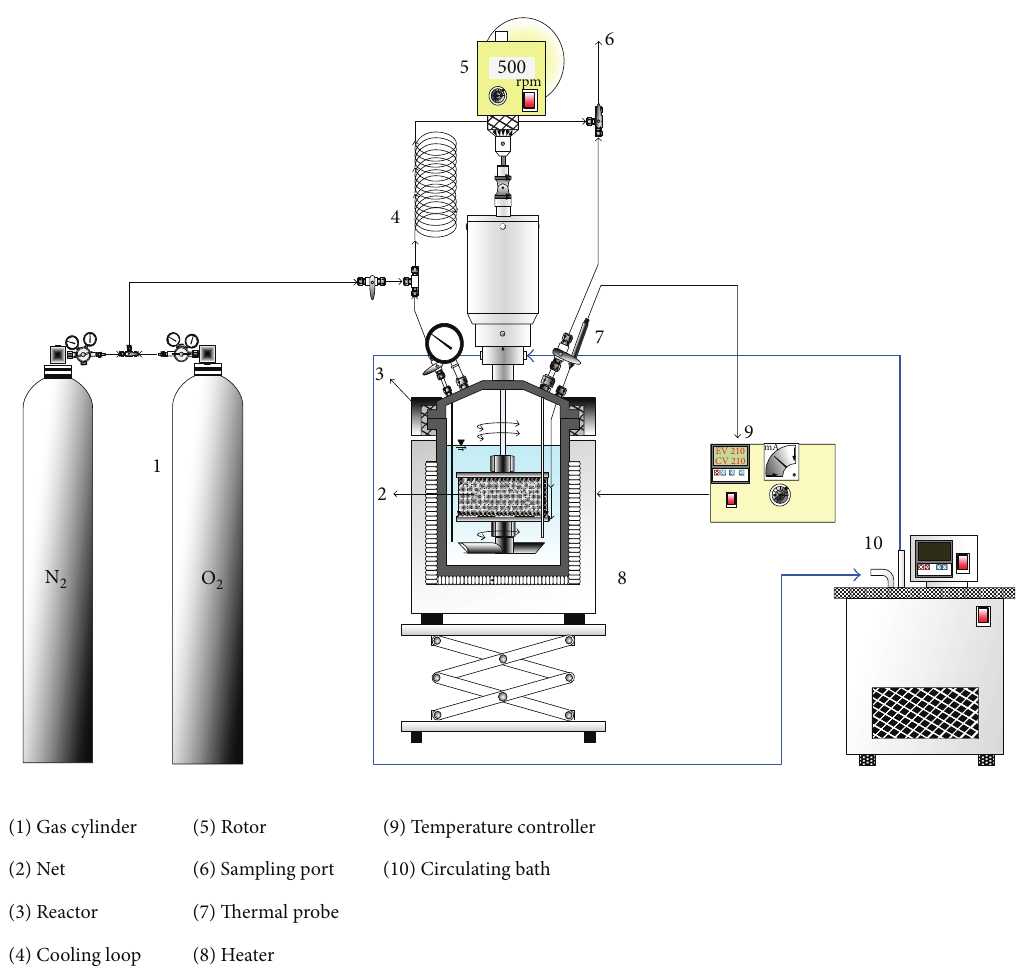
Figure 1: Schematic diagram of wet oxygen oxidation